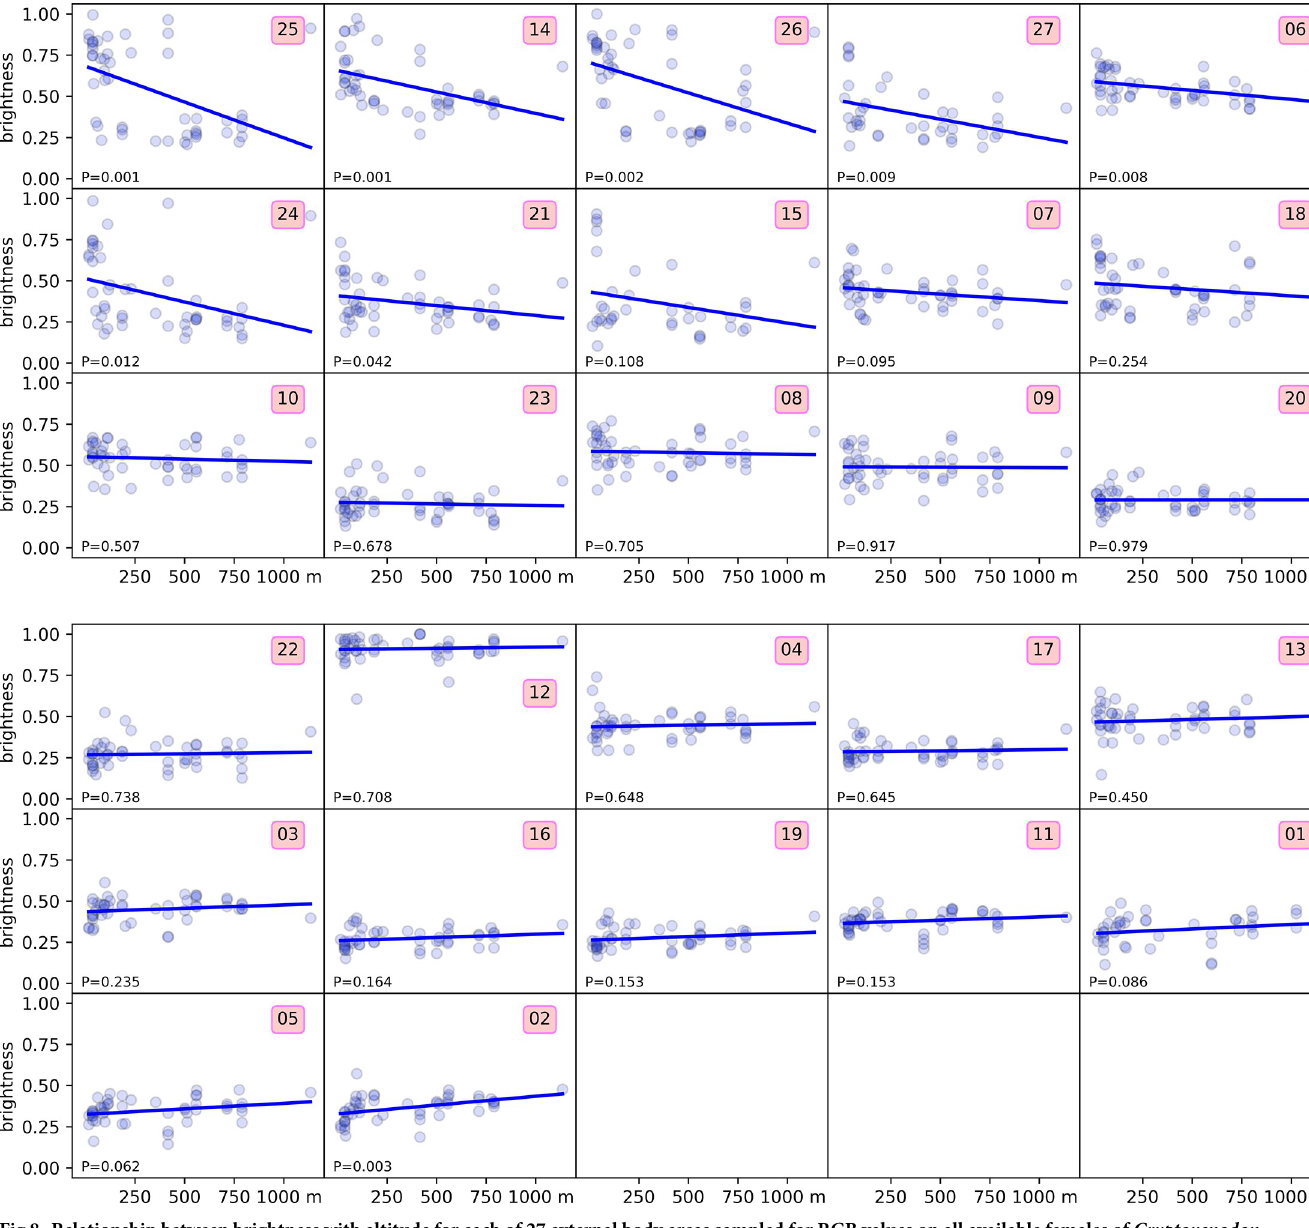
Fig 8. Relationship between brightness with altitude for each of 27 external body areas sampled for RGB values on all available females of Cryptoxenodon metamorphus sp. nov. (51 specimens). The number on each box inside the subplots corresponds to the sampled body area, acc. Table 1. Subplots ordered from the most decreasing to the most ascending curve (linear best fit). The respective P value is shown in each